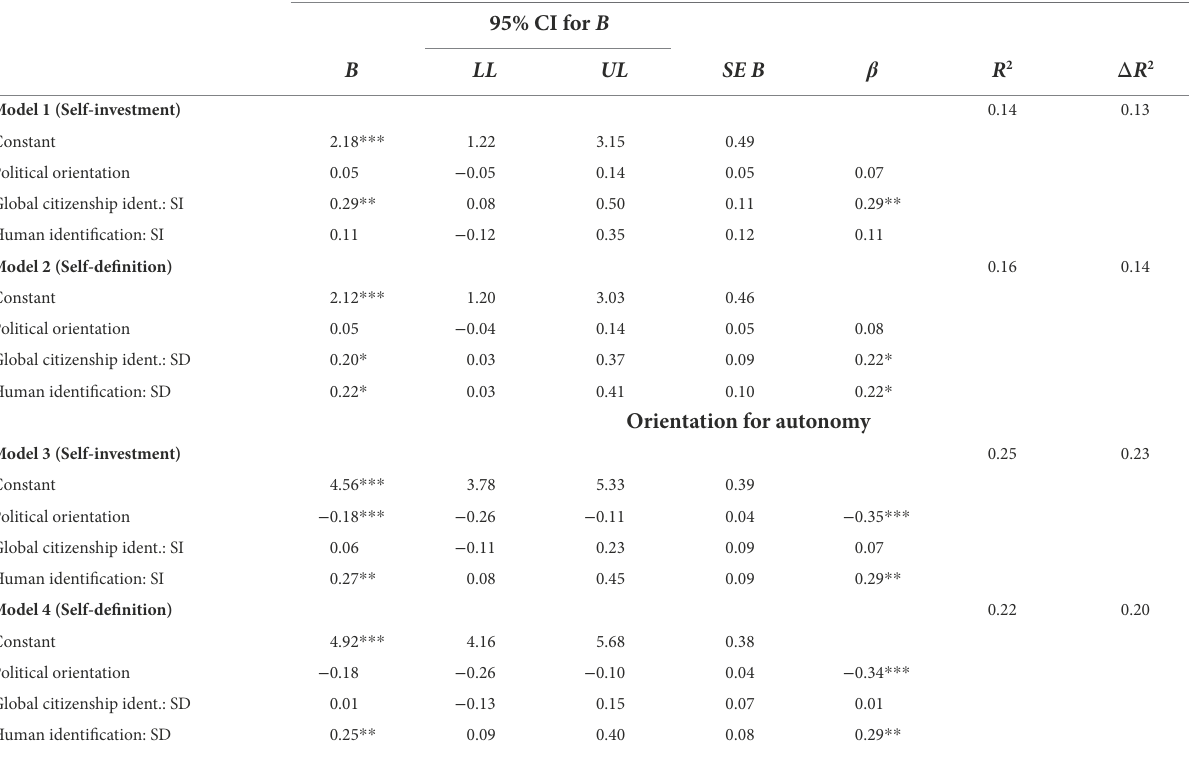
TABLE 3 Multiple regressions result for types of